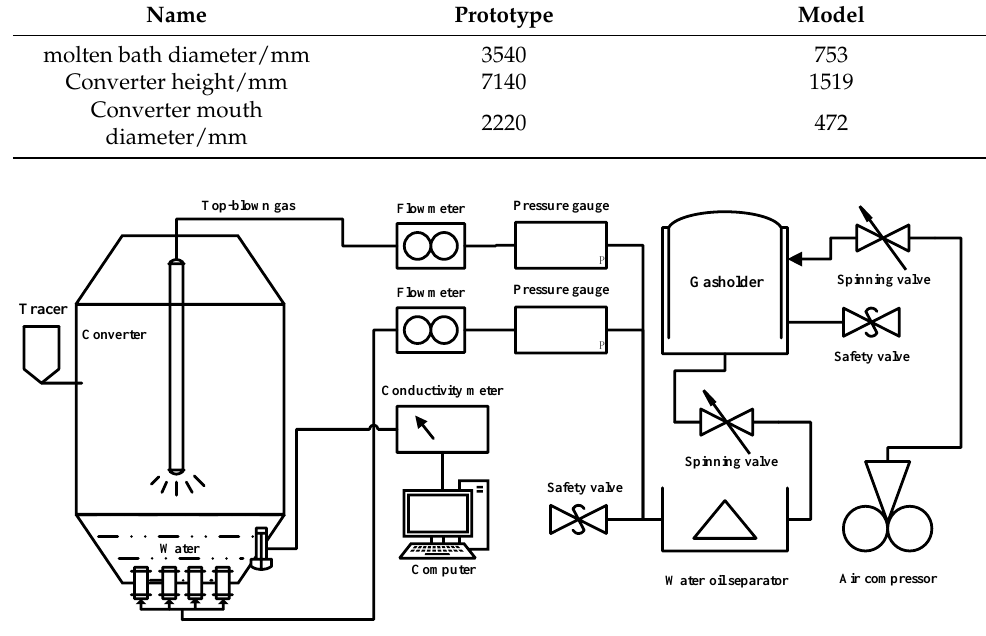
Figure 2. Diagram of the water model experimental